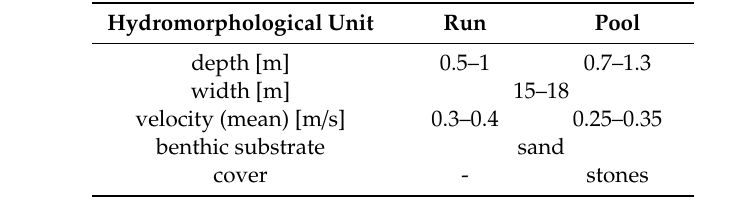
Table 2. Assumed parameter ranges for simulated maintenance works on the Swider River.